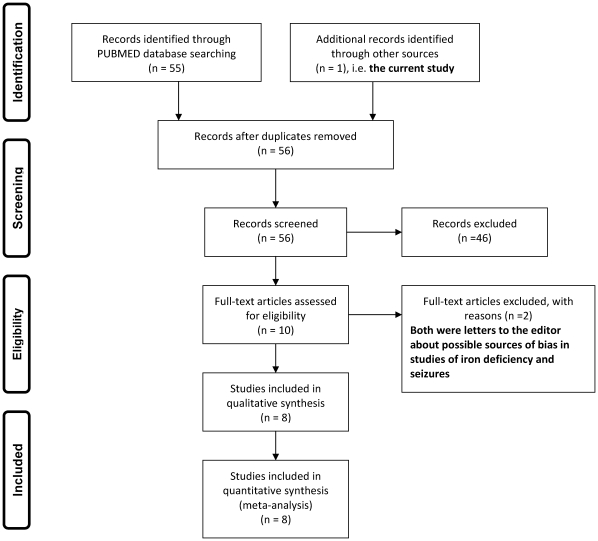
Study selection for the meta-analysis.Figure 1 is a flow diagram that shows the selection of studies for the meta-analysis investigating the association between iron deficiency and acute seizures in children.